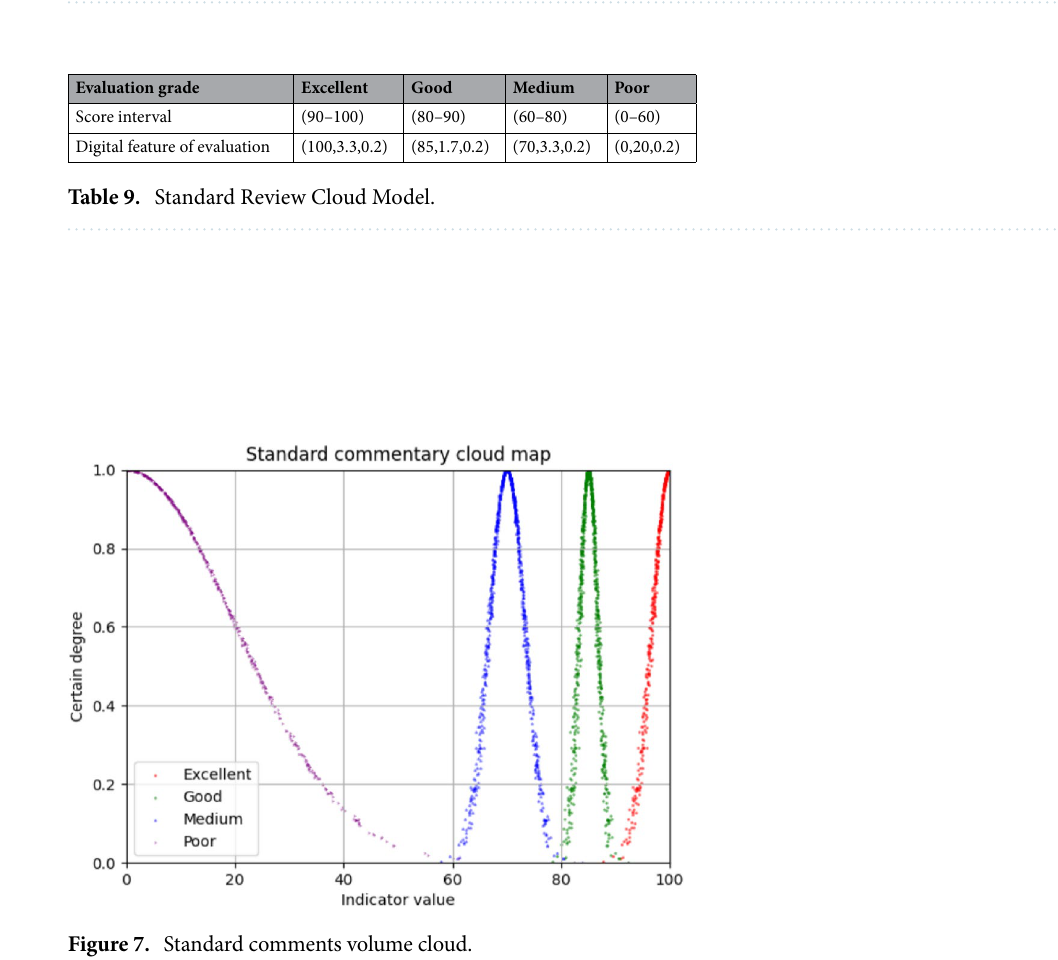
Table 8. Evaluation index and its weight.